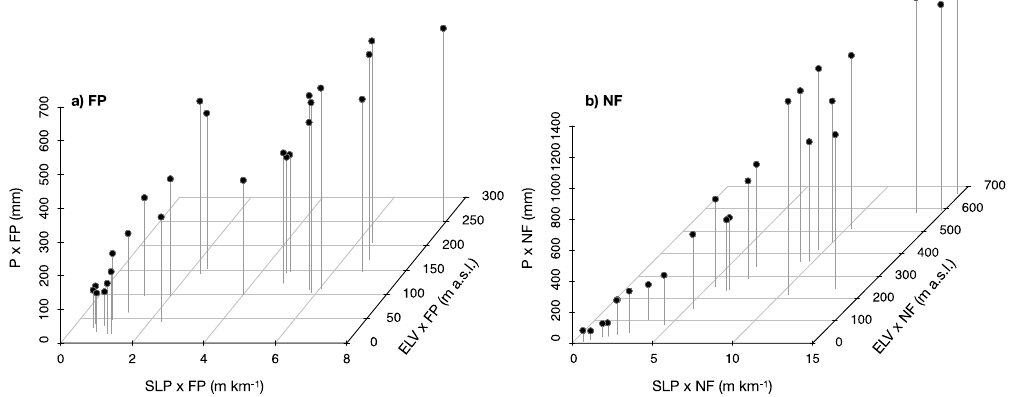
Figure 6. Correlation between mean slope (SLP), mean elevation (ELV) and mean annual precipitation (P), for FP (panel a ) and NF (panel b ). All variables are multiplied by the corresponding land cover fraction within the basin.